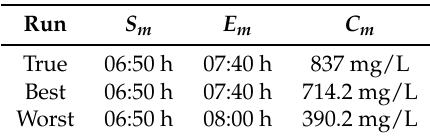
Table 6. Richmond network contamination event results comparison between true, best and worst of the total 30